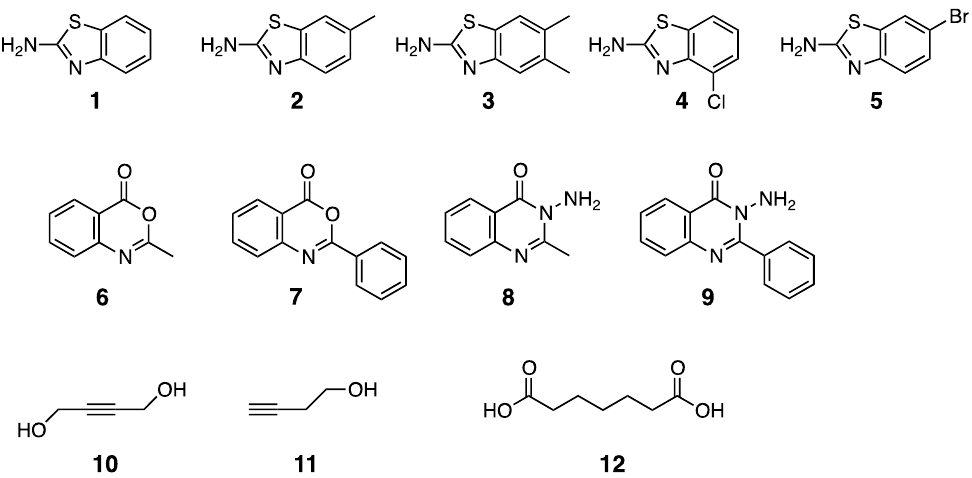
Figure 1. Molecular structures of the organic ligands used ( 1 : 2-aminobenzothiazole, 2 : 5-methyl- aminobenzothiazole, 3 : 5,6-dimethyl-2-aminobenzothiazole, 4 : 2-amino-4-chlorobenzothiazole, 5 : 2- amino-6-bromobenzothiazole, 6 : 2-methyl-4 H -3,1-benzoxazin-4-one, 7 : 2-phenyl-4 H -3,1-benzoxa- zin-4-one, 8 : 3-amino-2-methyl-4(3 H )-quinazolinone, 9 : 3-amino-2-phenyl-4(3 H )-quinazolinone, 10 : 2-butyne-1,4-diol, 11 : 3-butyn-1-ol, 12 : heptane-1,7-dioic).